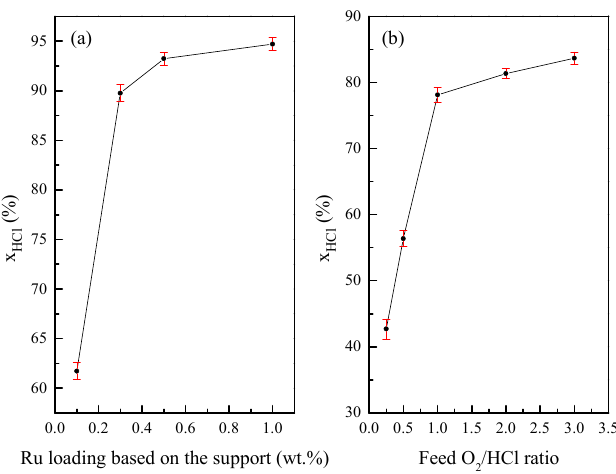
Figure 9. The influence of Ru loading at 350 °C ( a ) and feed O 2 /HCl ratio at 320 °C ( b ) on HCl conversion. Note volumetric flowrate HCl/O 2 = 1:2 for ( a ).